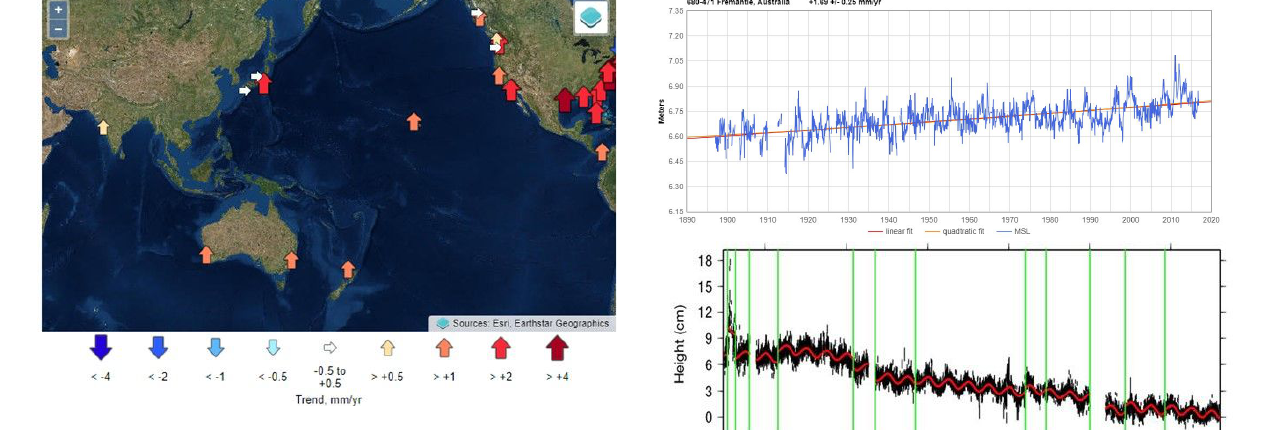
Figure 1: Relative sea-level rise in the stations with enough data from 1900 to 2015 according to [16]. Image modified after [16].